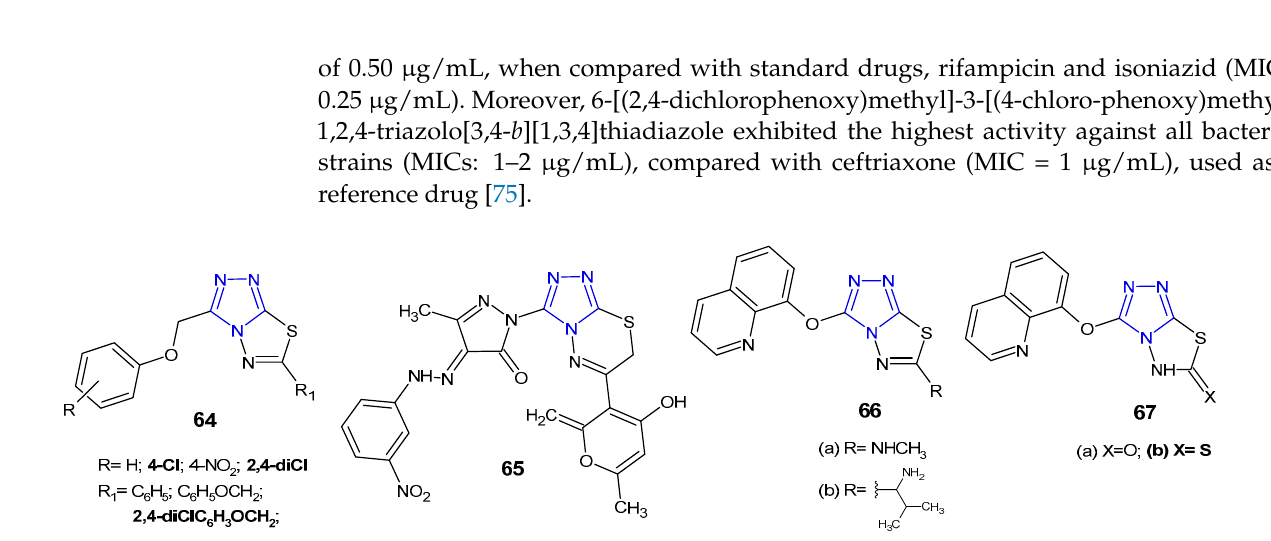
Figure 21. Antibacterial derivatives of 1,2,4-triazolo[3,4- b ][1,3,4]thiadiazoles and 1,2,4-triazolo[3,4- b ][1,3,4]thiadiazines— continued.